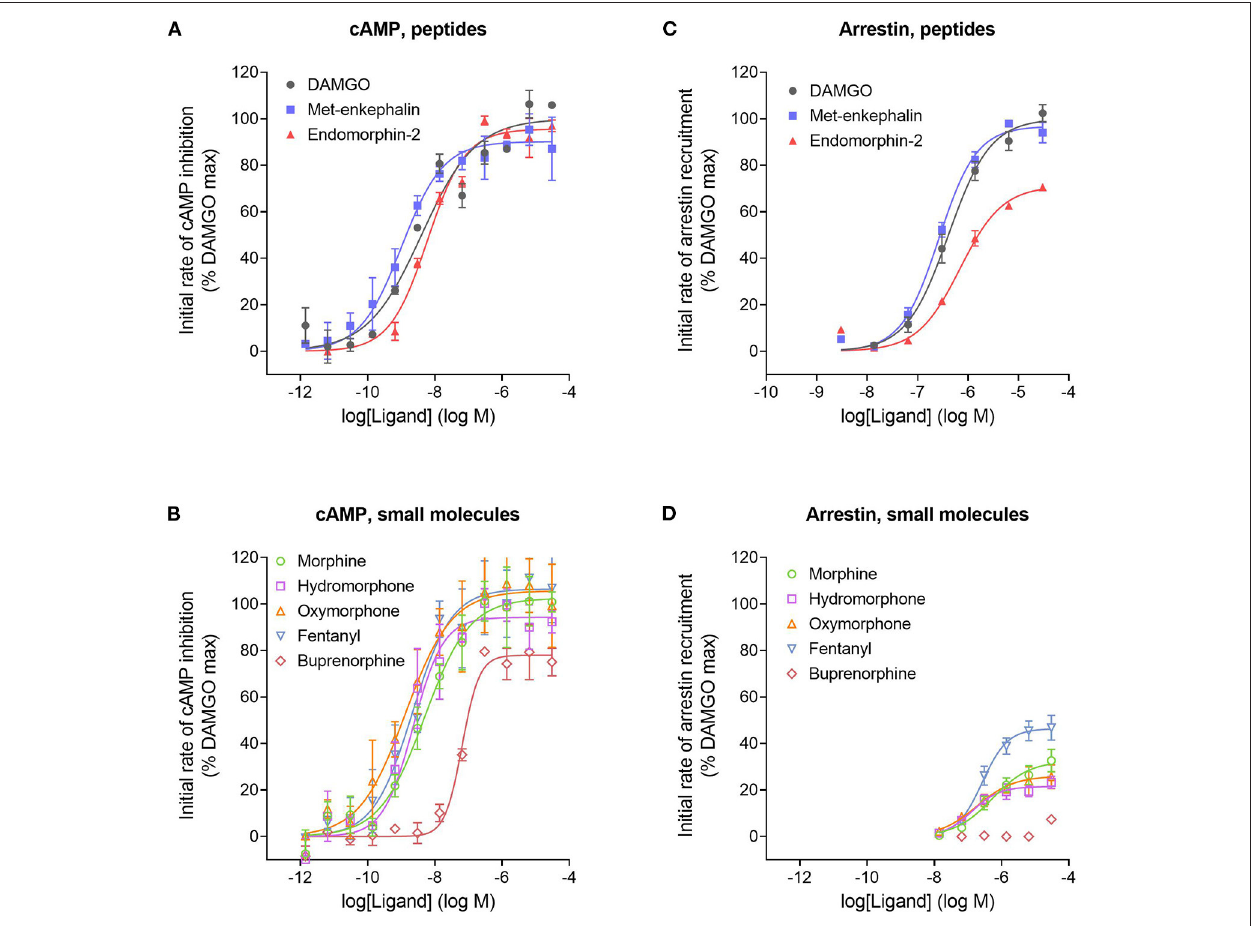
FIGURE 4 | Initial rate of signal generation by the µ opioid receptor in response to endogenous peptide ligands (A,C) and small molecule therapeutics (B,D) . The initial rate of cAMP inhibition (A,B) and arrestin recruitment (C,D) was calculated from the time course data curve fit parameters ( Figure 3 , Supplementary Figures 1, 2 ). Data points are the mean ± SEM from two separate experiments. The curves were generated using the sigmoid curve equation ( Motulsky, 2019), defined by the average curve fit values from the two experiments from Supplementary Table 1 . Note that the small molecules are all partial agonists for generating arrestin